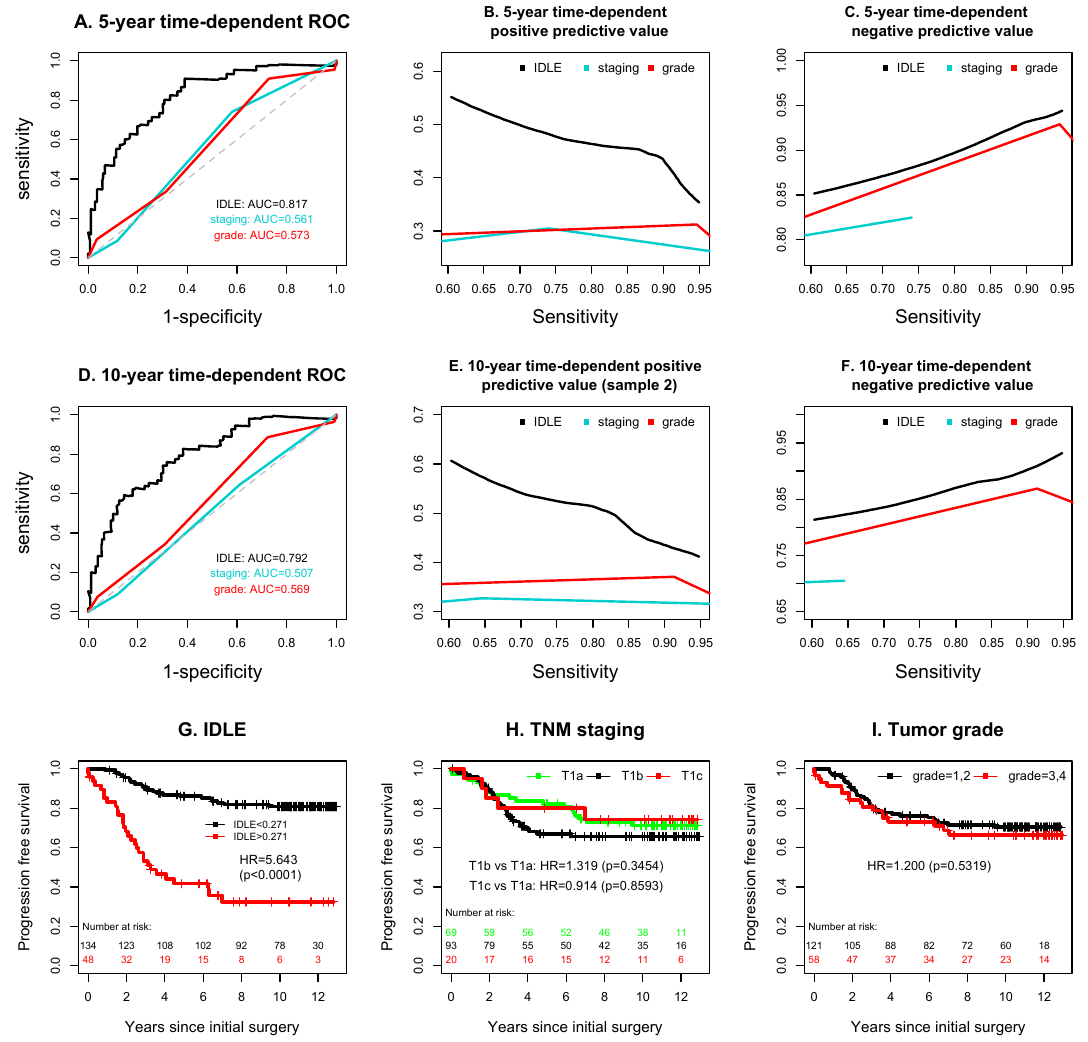
Figure 4. Prediction accuracy comparison of IDLE, TNM staging, and tumor grade. Negative predictive values for TNM staging were evaluable only in a part of sensitivity regions since higher sensitivities were not reached. The patients with undetermined (GX) tumor grade were excluded from the Kaplan–Meier curves in plot I.